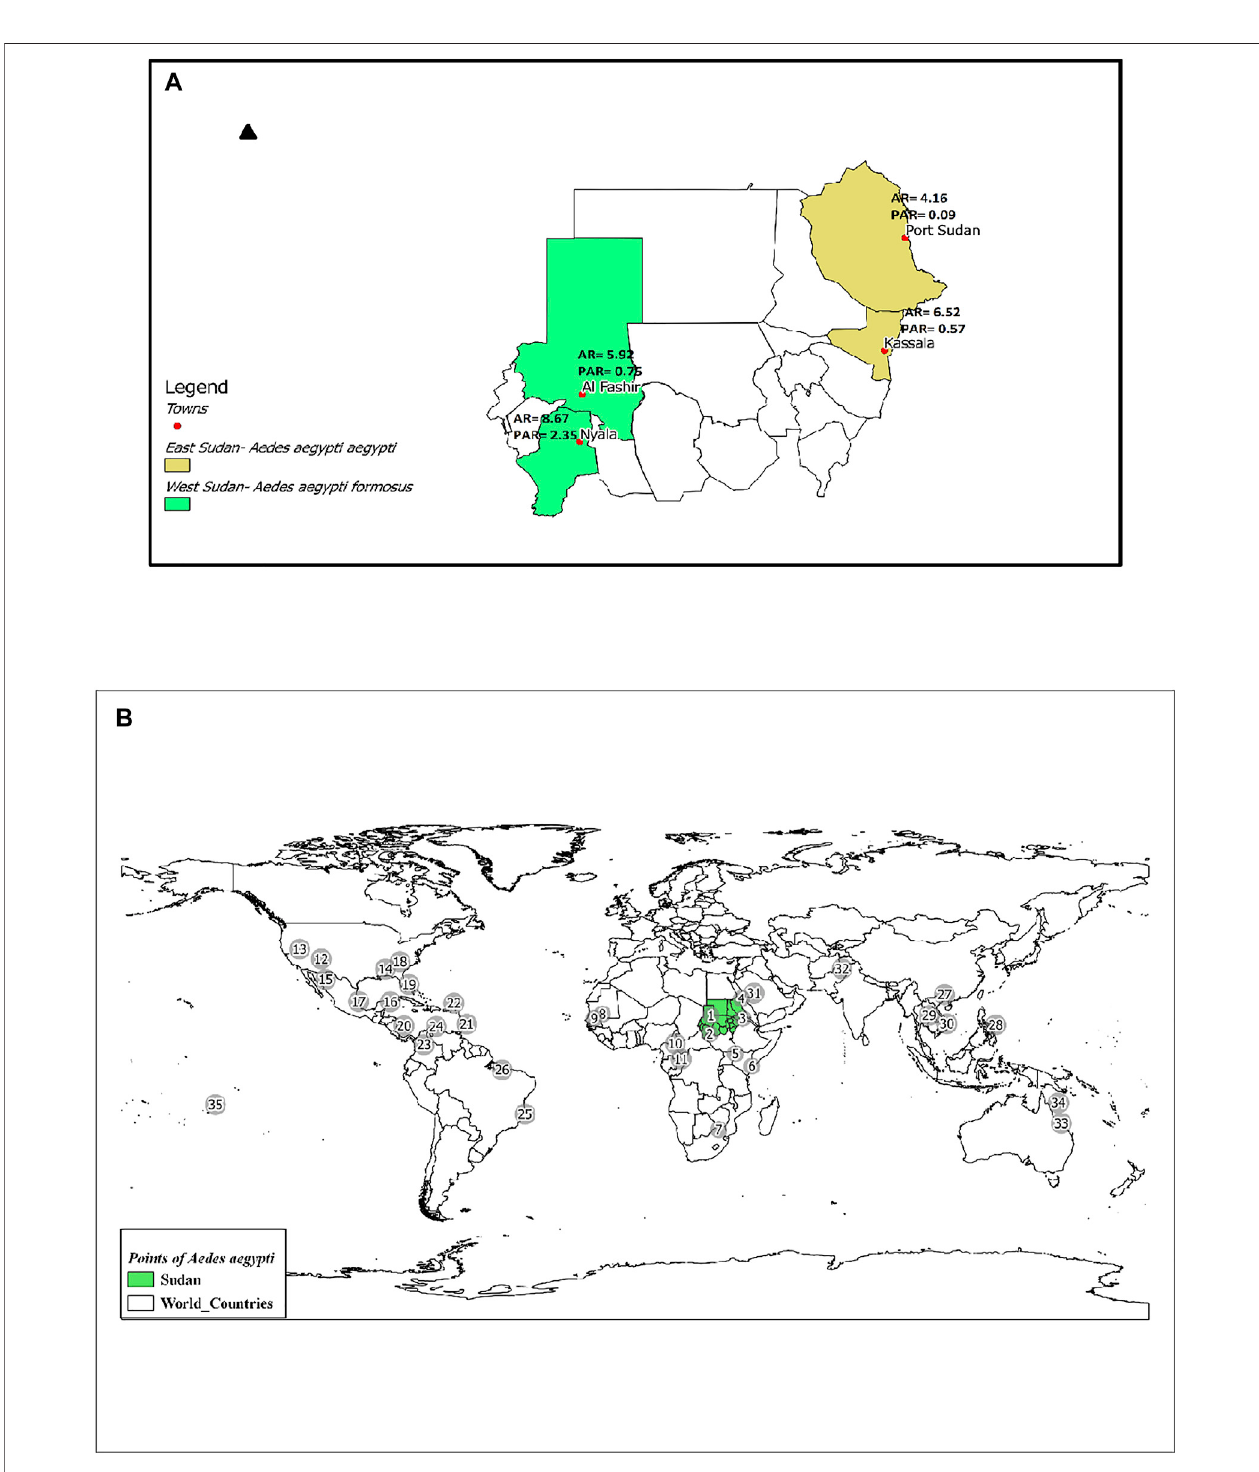
FIGURE 1 | (A) Map of Sudan showing the locations of the two subspecies/forms of Ae. aegypti collected from four sites. AR = Allelic Richness and PAR = Private Allelic Richness. (B) . Map showing locations of Ae. aegypti included in this study. Population codes are as labeled in Supplementary Table S1. Shape fi le downloaded from https://mapcruzin.com/